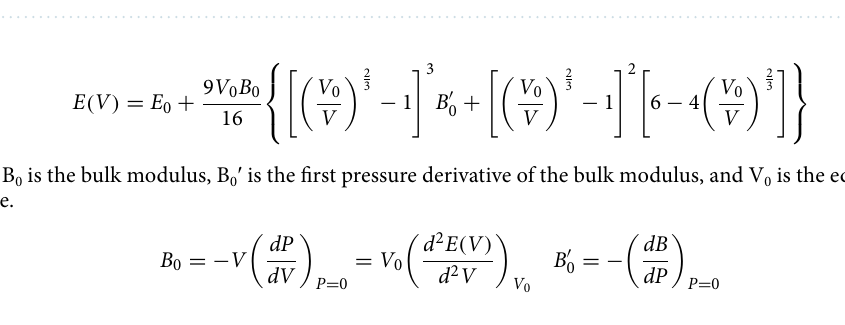
Figure 3. Volume ratio and pressure relation of Mg–B compounds with an interval of 10